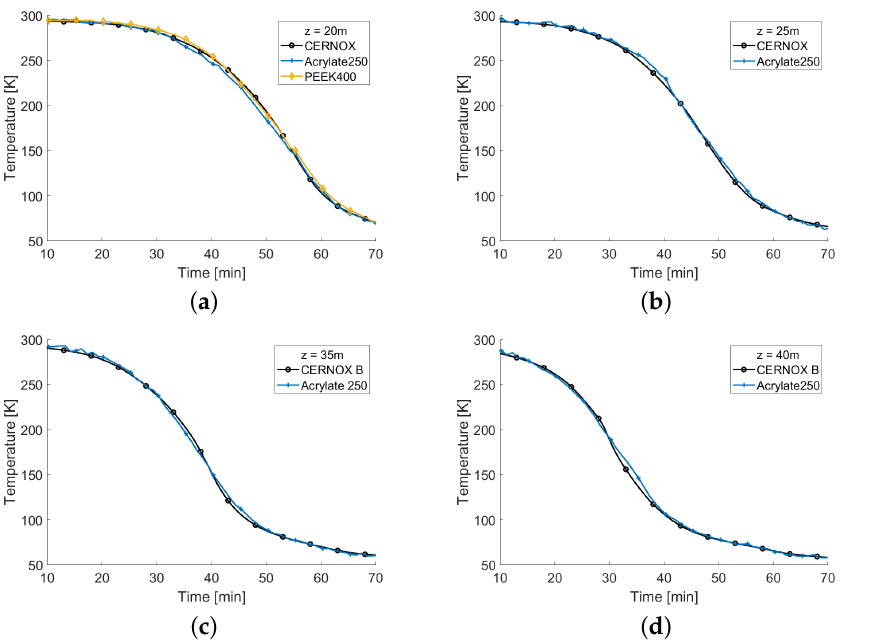
Figure 9. Comparison between temperatures measured with the fibers and that measured by the CERNOX at z = 20m ( a ), 25m ( b ), 35m ( c ), and 40m ( d ).